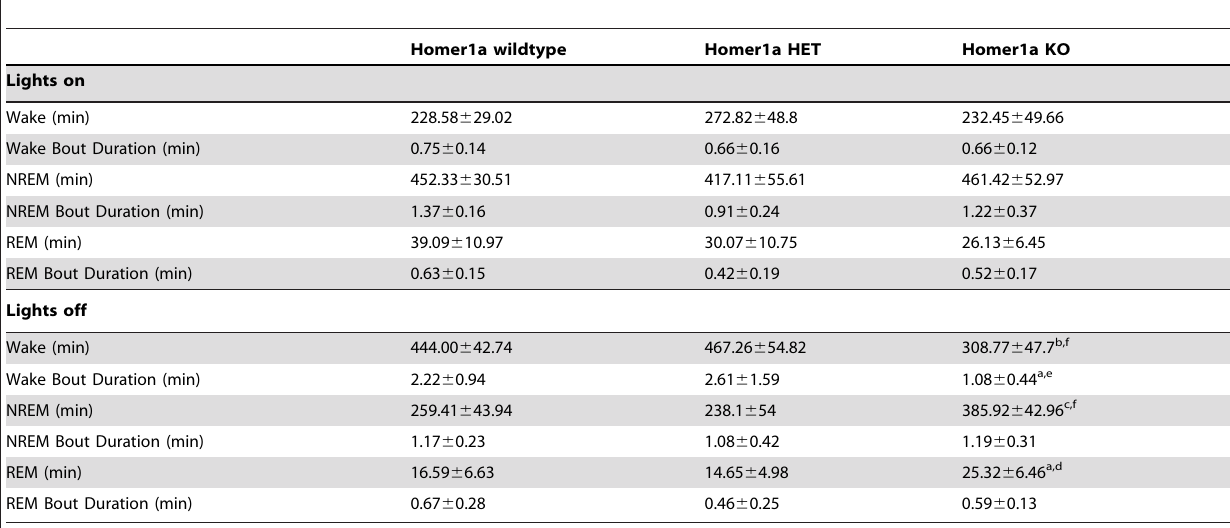
Table 2. Comparison of sleep wake data in Homer1a knockout, Homer1a heterozygote and wildtype littermate mice during the lights off and lights on